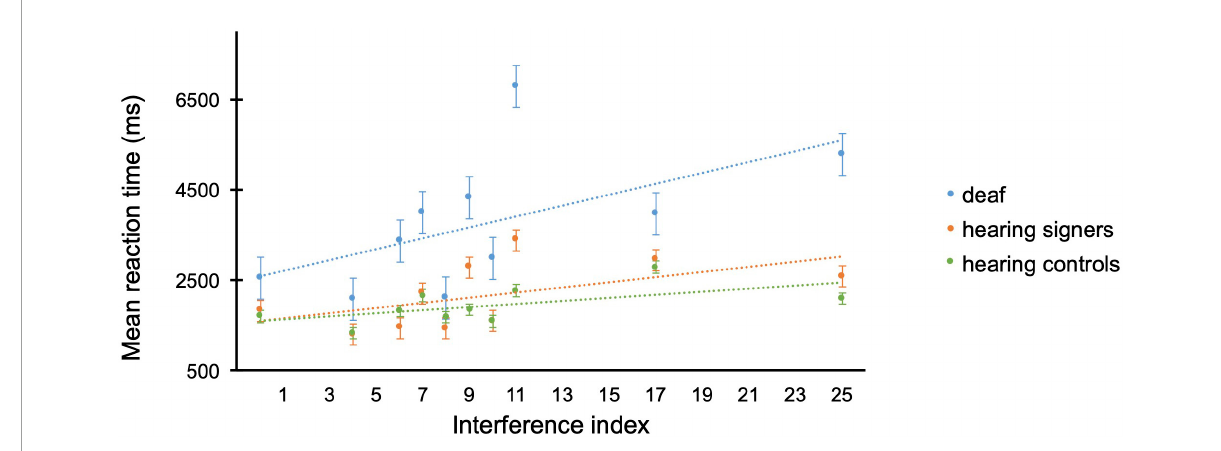
FIGURE2 Mean reaction times (ms) per interference index for the easy multiplication operations in the different groups (deaf in blue, hearing signers in orange, hearing controls in green) of the arithmetic task. Error bars represent the standard error of the means.